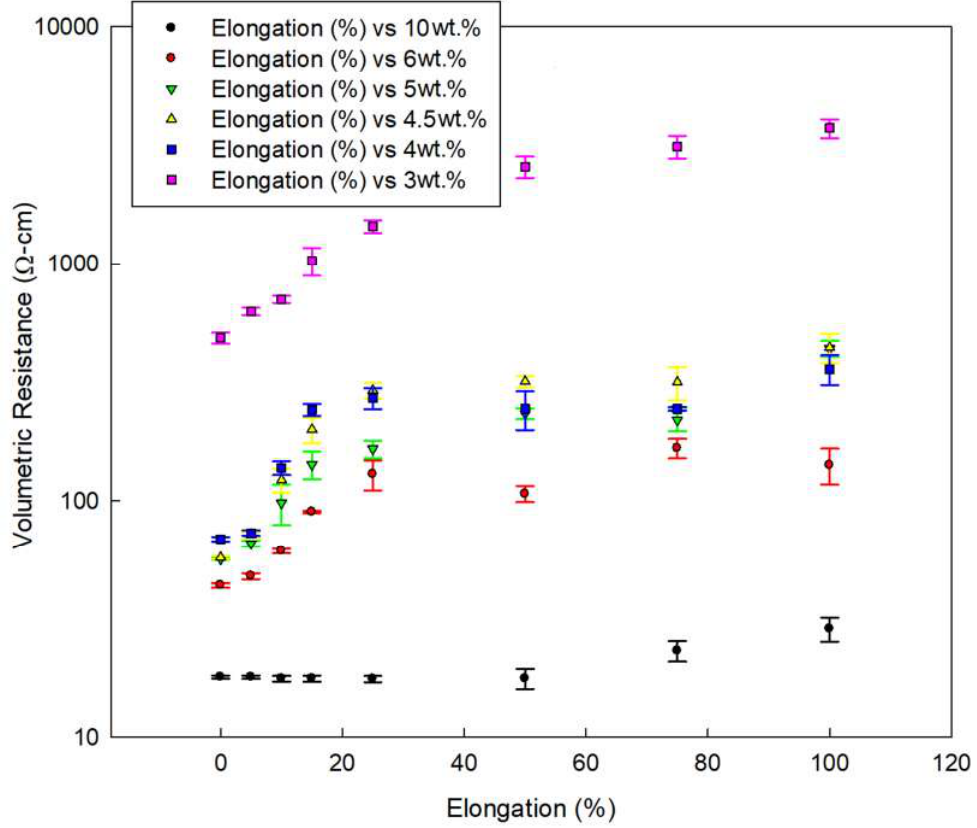
Figure 8. MWCNT / VMQ conductivity change with first cycle deformation, at various CNT Figure 8. MWCNT/VMQ conductivity change with first cycle deformation, at various CNT concentrations.